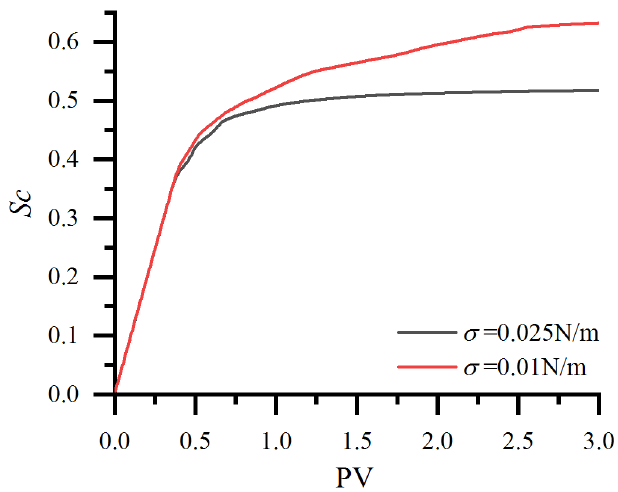
Figure 17. Saturation ( S C ) vs. PV for different interfacial tension.